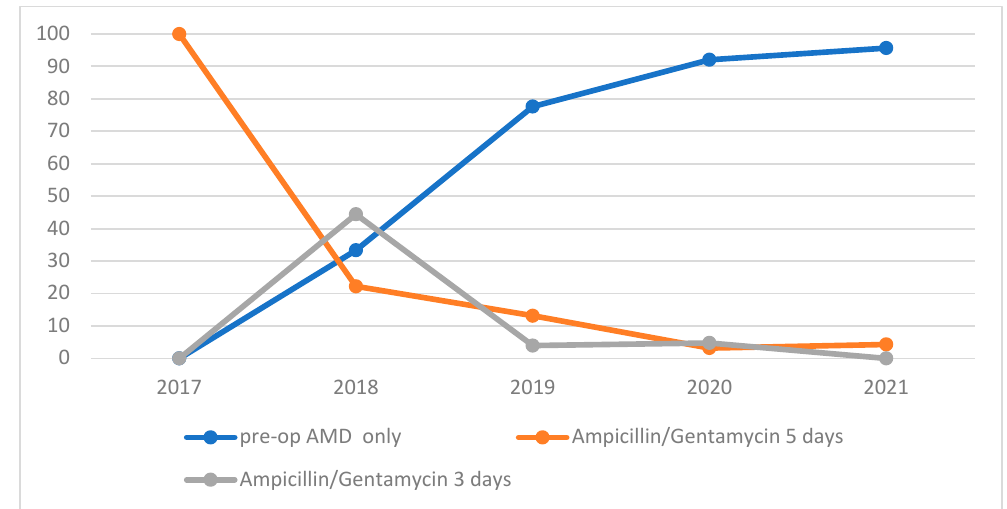
Figure 1. Use of antimicrobial drugs during the years in our referring center. Table 2. Data of antimicrobial administration in the postoperative period and reason behind this approach. (SSI: surgical site infection; DPJ: duodenitis–proximal jejunitis).